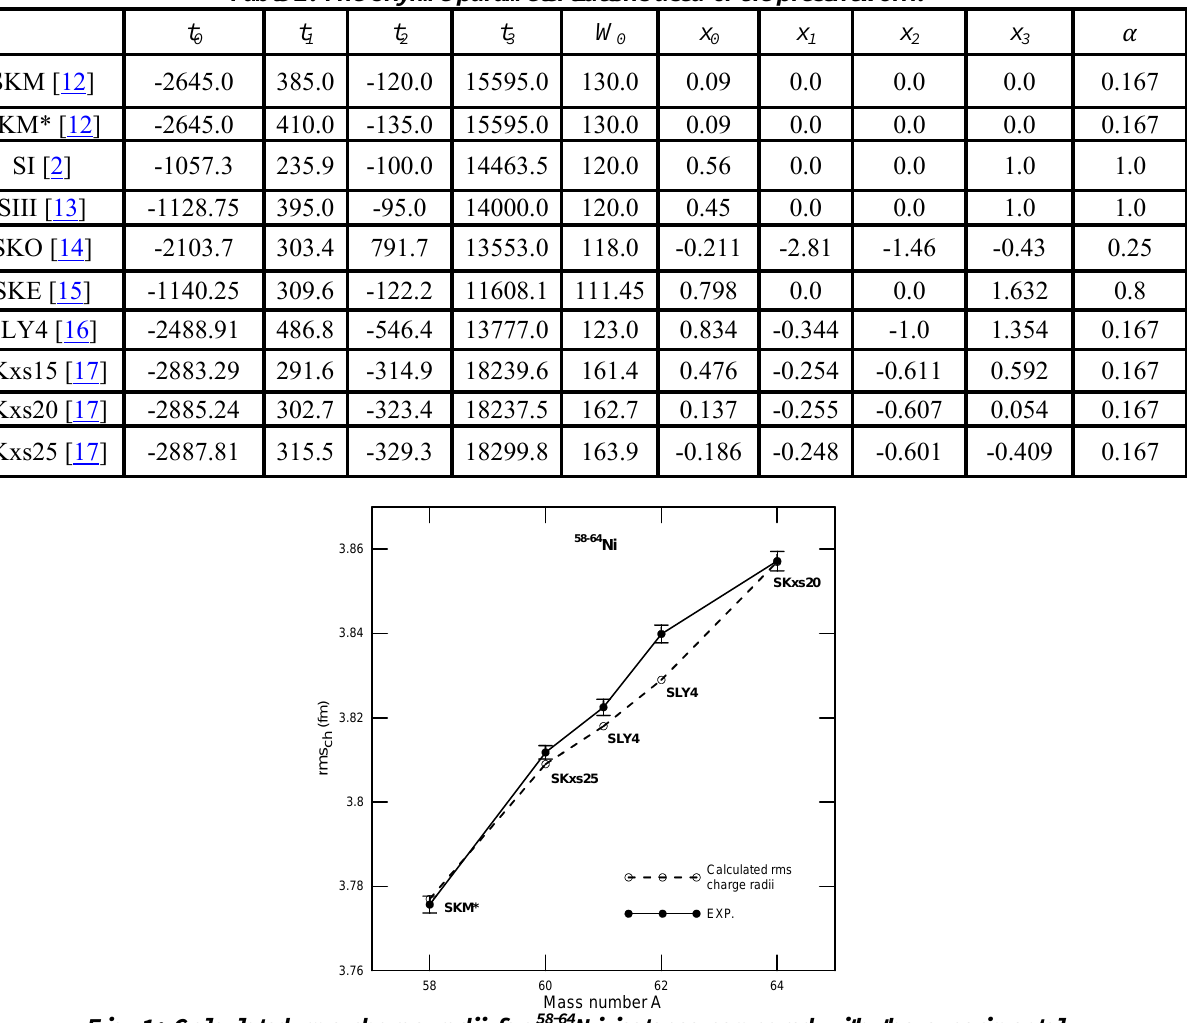
Table 1: The Skyrme parameterizations used in the present work.